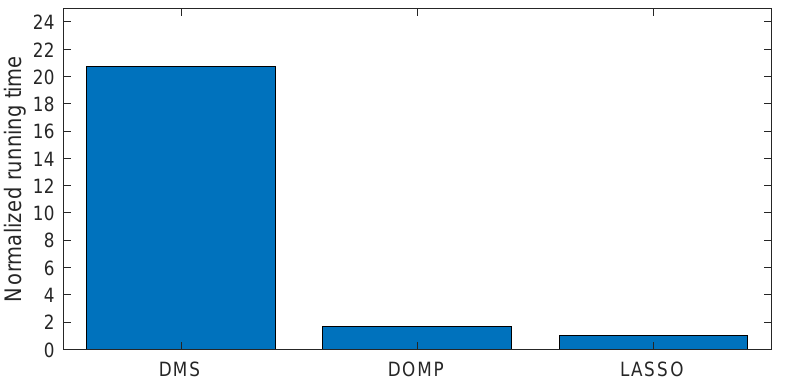
Figure 13. Normalized running time considering DOMP, DMS and LASSO feature selection tech- niques in order to select the best 200 coefficients.